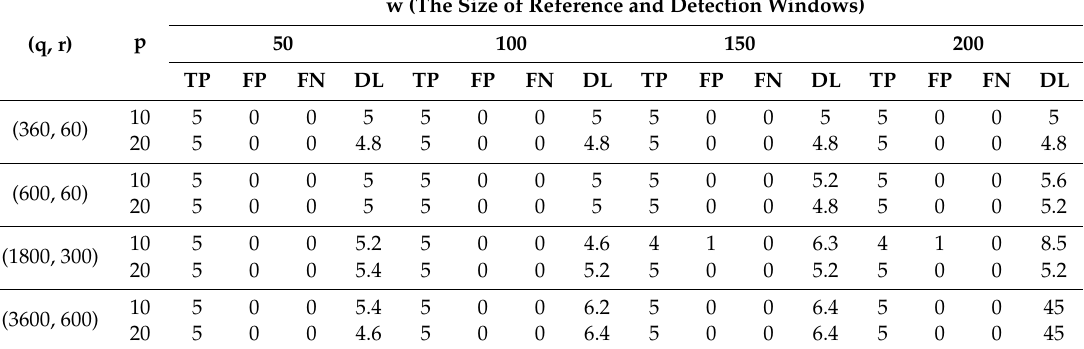
Table 2. PD detection performance for void type (q: the number of phase windows accumulated in a single cycle, r: the number of forward-moving phase windows).